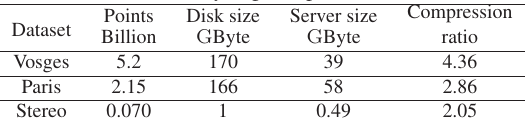
Table 4: Analysing compression ratio.